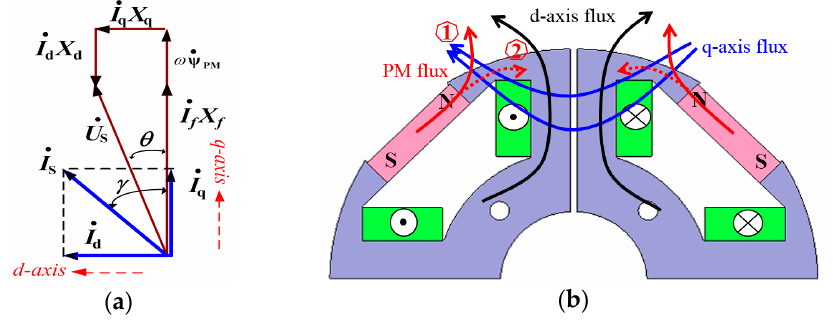
Figure 3. ( a ) Vector diagram in d-q reference frame; ( b ) Magnetic flux path on the rotor.